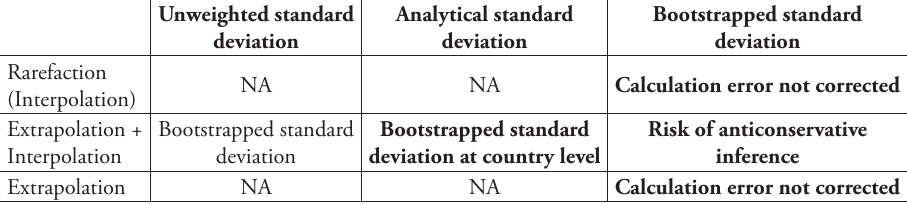
Table 2. Species number statistics. CA2013 presents standard deviations of species number change es- timated in different ways and at different sampling efforts (NA: not available). Each of these statistics available from the paper or its figures is calculated in an unexpected manner. Categories where remarks are in bold are used for the